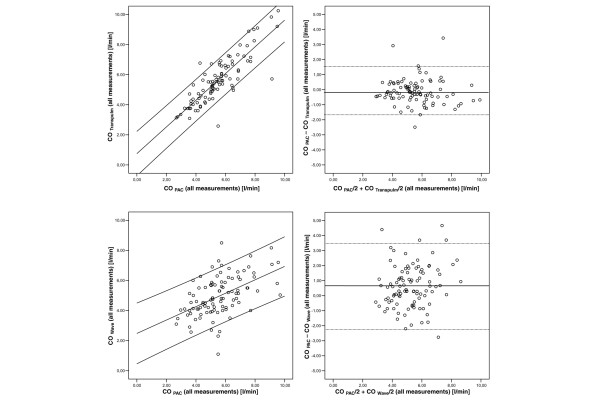
Regression analysis and Bland-Altman plots of COPAC versus COWave and of COPAC versus COTranspulm for overall measurements. COPAC, pulmonary artery catheter thermodilution cardiac output; COTranspulm, aortic transpulmonary thermodilution cardiac output; COWave, uncalibrated pulse contour cardiac output.